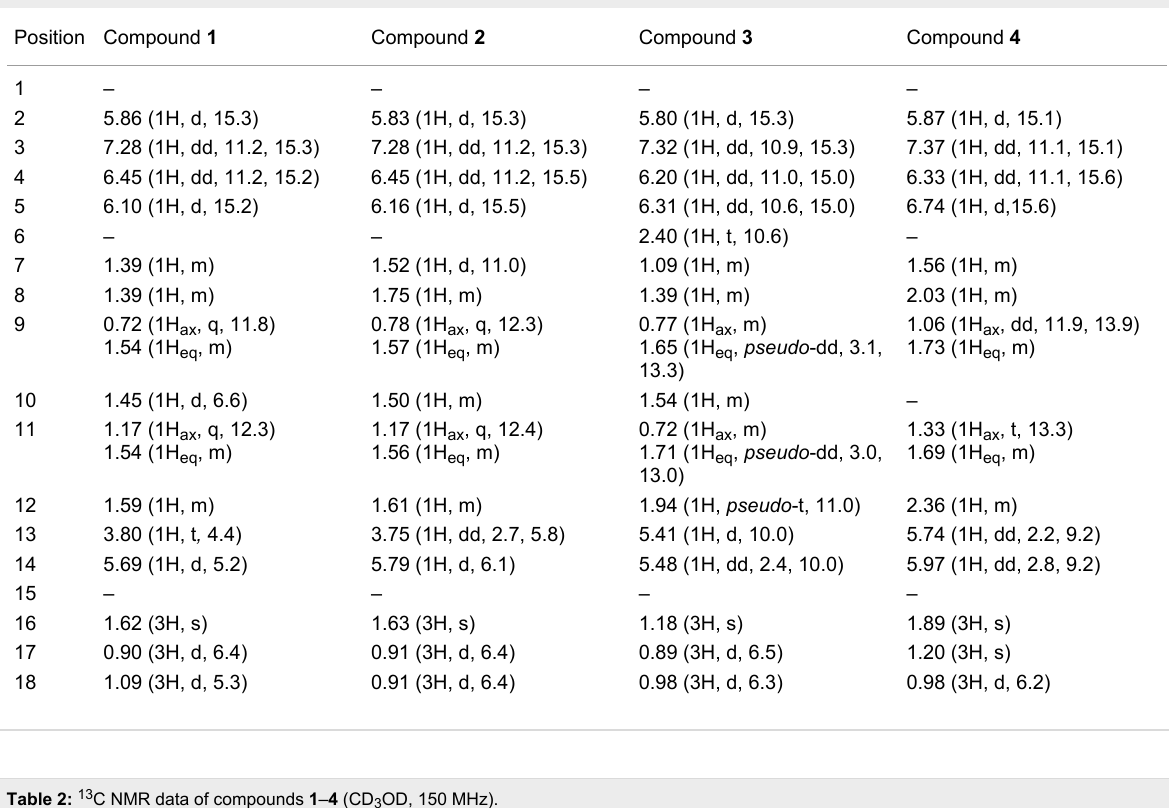
Table 1: 1 H NMR data of compounds 1 – 4 (CD 3 OD, 600 MHz).